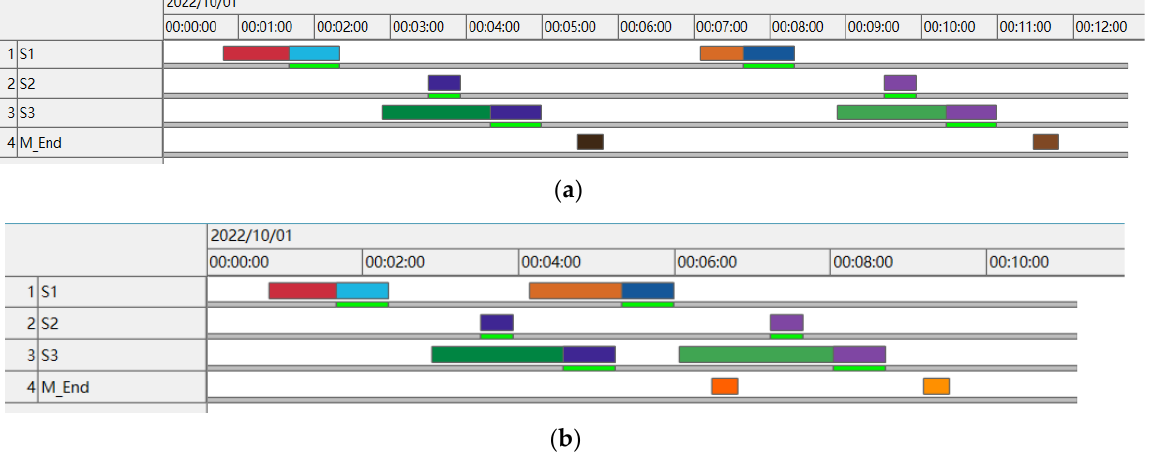
Figure 14. Gantt chart of different AGV scheduling strategies. ( a ) Gantt chart of the traditional scheduling; ( b ) Gantt chart of the real-time dynamic task list scheduling.